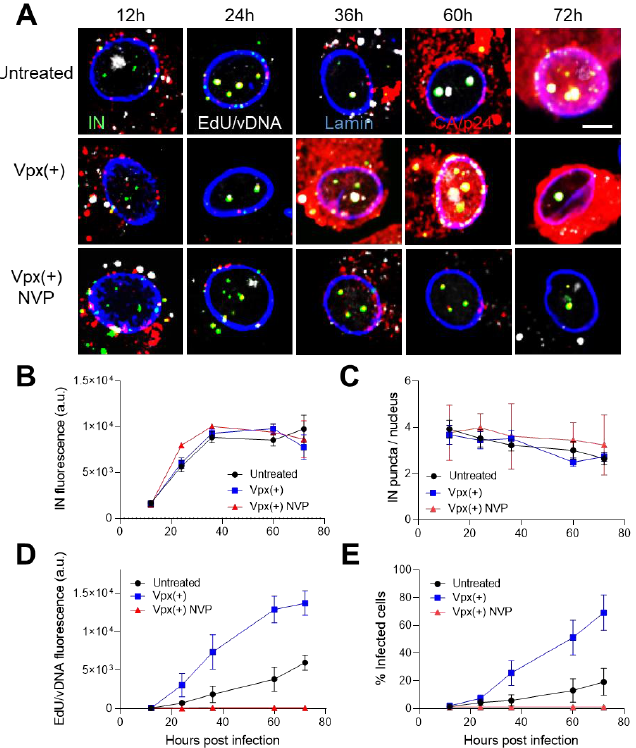
Figure 5. HIV-1 cDNA synthesis in MDMs continues past nuclear import and clustering of VRCs. MDMs pretreated with SIV-VLP Vpx(+) or left untreated were infected with VSV-G-pseudotyped HIV-1 labeled with INsfGFP (MOI 5) in the presence of EdU (5 μM). Cells were cultured for 72 h without removing the virus from the medium, fixed at the indicated time points, and stained for EdU and CA. Where indicated, the reverse transcriptase (RT) inhibitor nevirapine (NVP, 10 μM) was added to Vpx(+)-treated MDMs at the time of infection. ( A ) Representative images of MDM nuclei at different times post-infection showing INsfGFP (green), EdU/vDNA (white), CA/p24 (red), and lamin (blue). Diffuse CA signal in the cytoplasm appearing at 36, 60, and 72 hpi in Vpx(+) and at 60 and 72 hpi in untreated samples is a result of Gag/GagPol synthesis in productively infected cells. MDM nuclei were analyzed for INmNG fluorescence ( B ), the number of IN puncta per nucleus ( C ), IN puncta-associated EdU signal ( D ), and the fraction of infected cells ( E ), as a function of time. Scale bar in ( A ) is 5 μm. Error bars in ( B – E ) are SEM and mean from 30–40 nuclei for each condition and are representative for 2 donors.